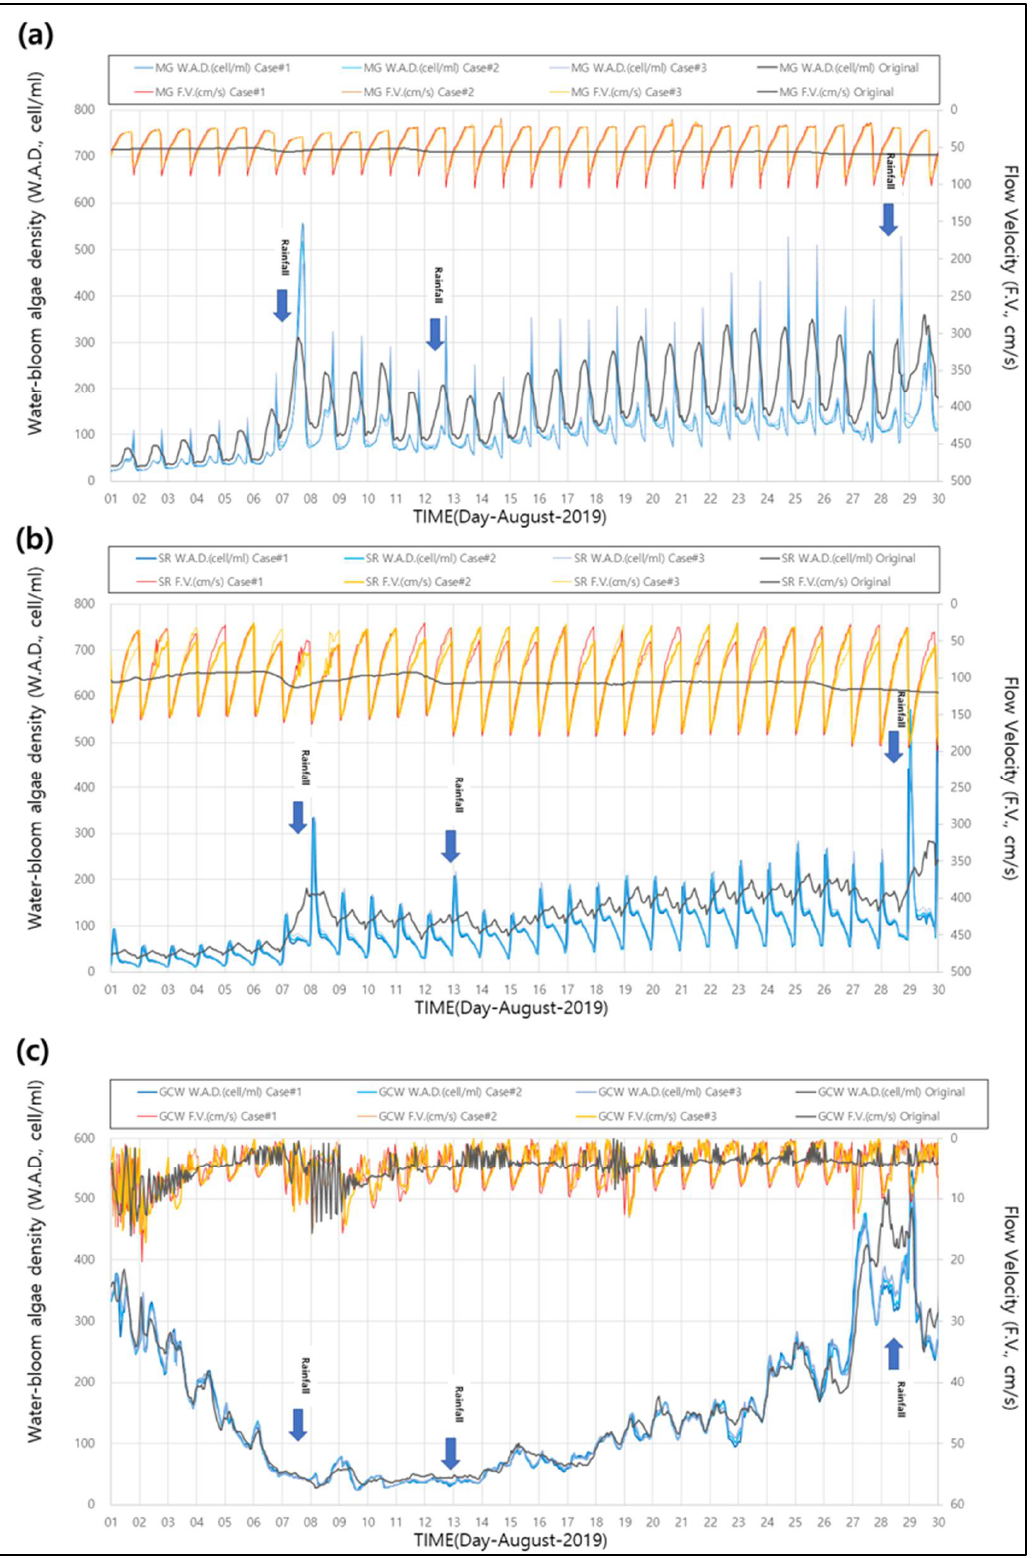
Figure 6. Simulation result of oscillation flow with EFDC-NIER model: ( a ) Mokgye, ( b ) Seom river junction, ( c ) Gangcheon Weir.